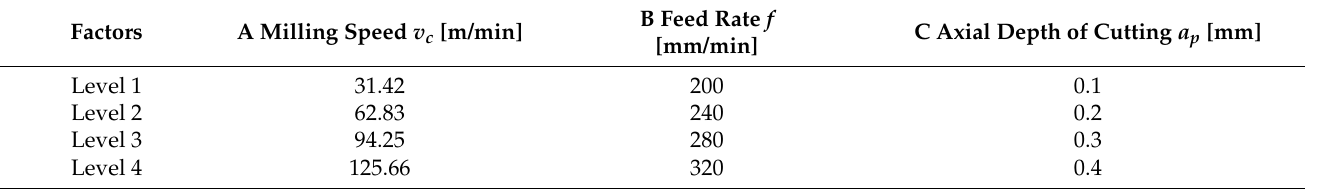
Table 3. The orthogonal program of milling parameters.